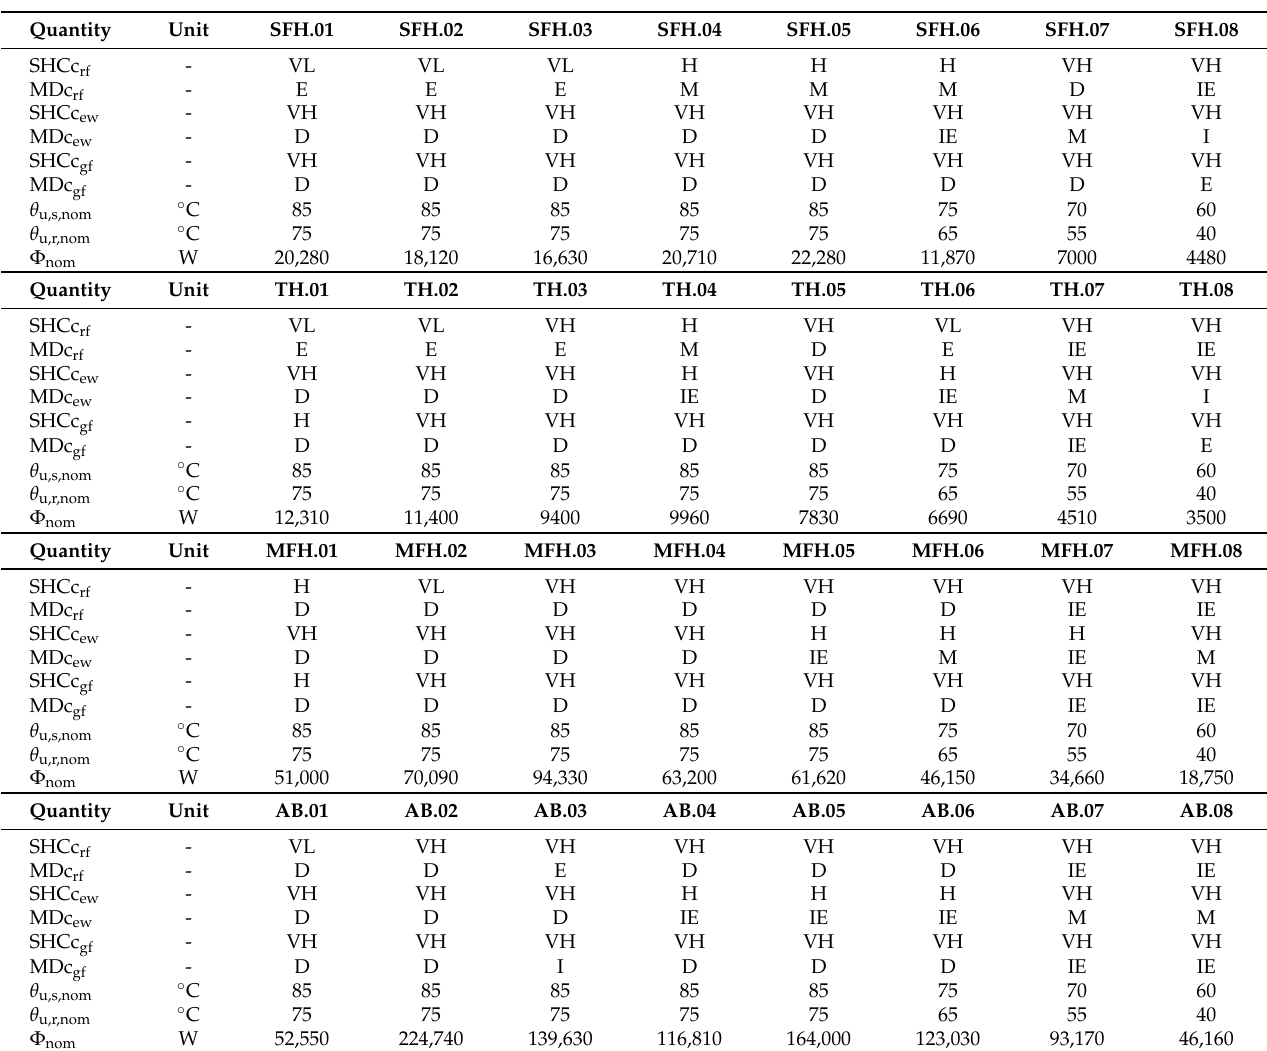
Table 1. Additional information for the Italian building typology matrix (MDc: mass distribution class, according to Reference [37], Table 1; SHCc: specific heat capacity class, according to Reference [34], Table A.14). Subscripts “rf”, “ew” and “gf” indicate roof, external walls and ground floor elements, respectively.